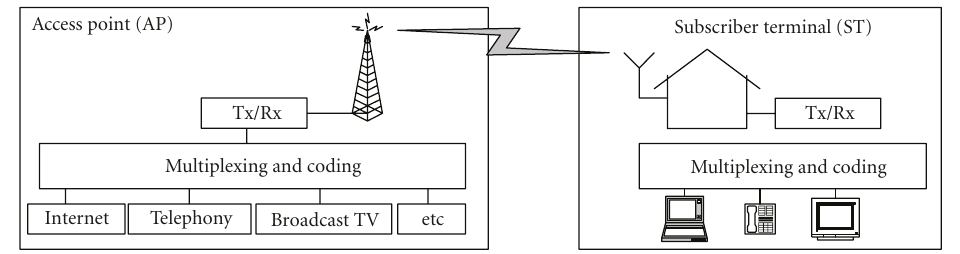
Figure 2: BFWA system providing a mix of service to home network.